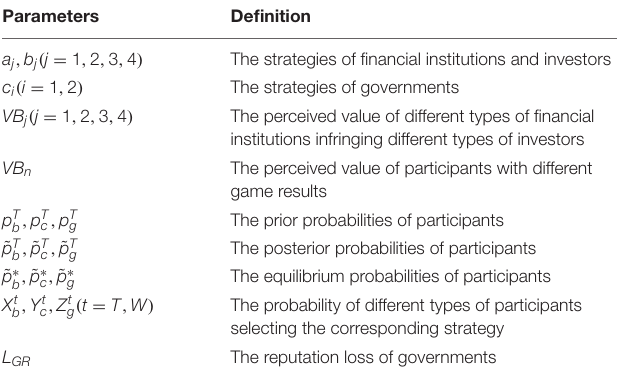
TABLE 1 | The main parameters of the game model.